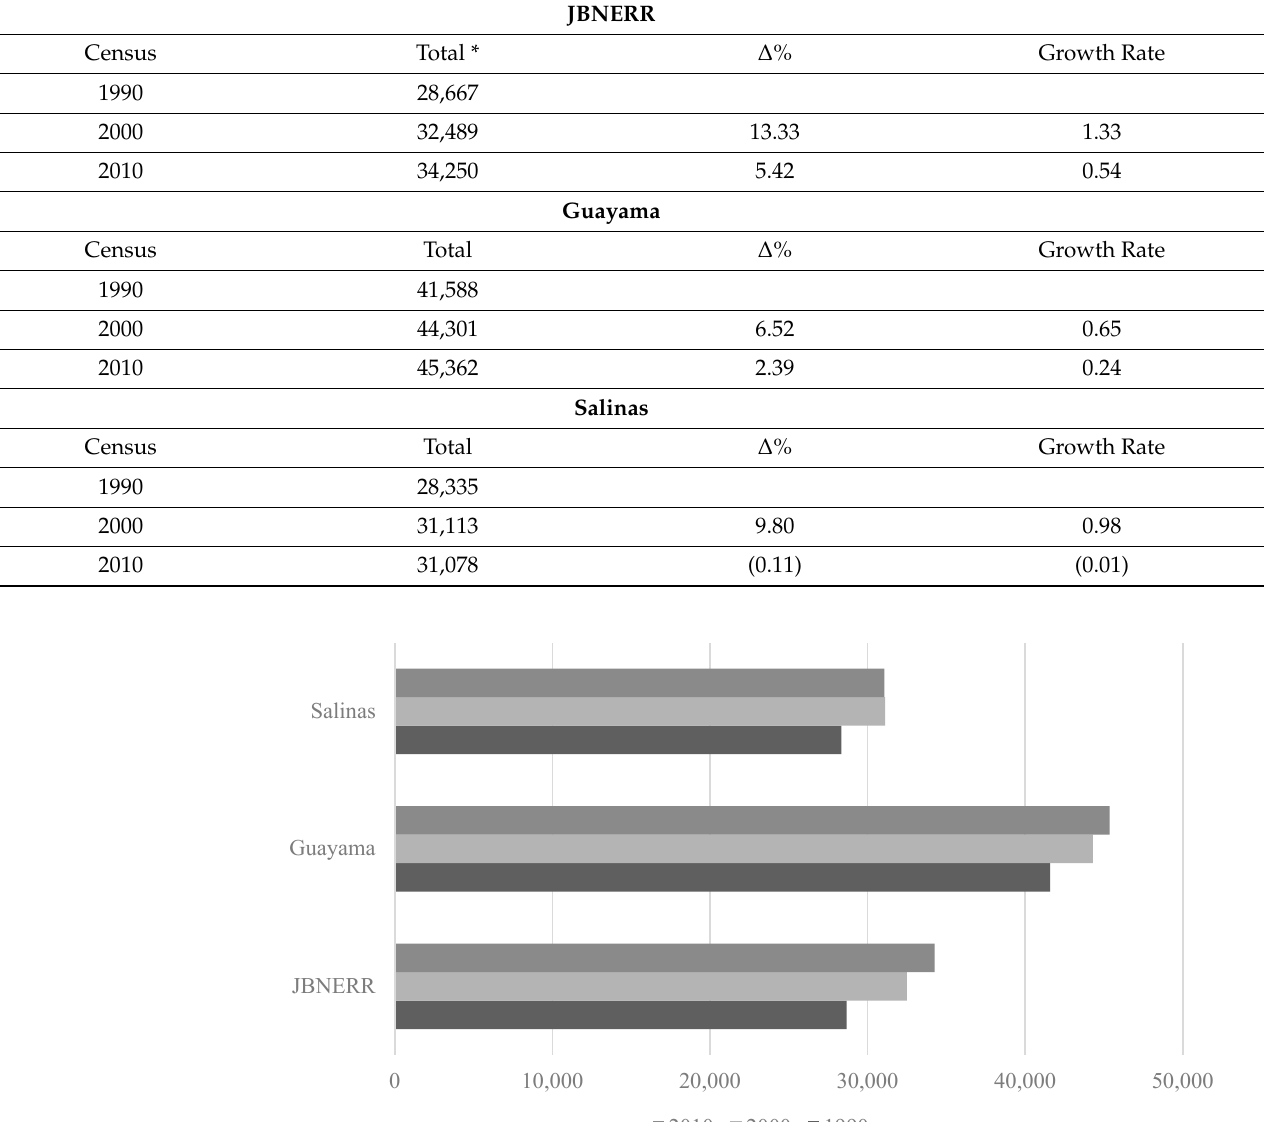
Table 1. Total population comparison between the study area and Guayama and Salinas municipalities.